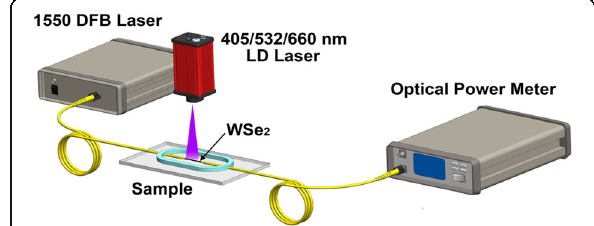
Fig. 6 Experimental setup for measuring TOP of the device under external laser light